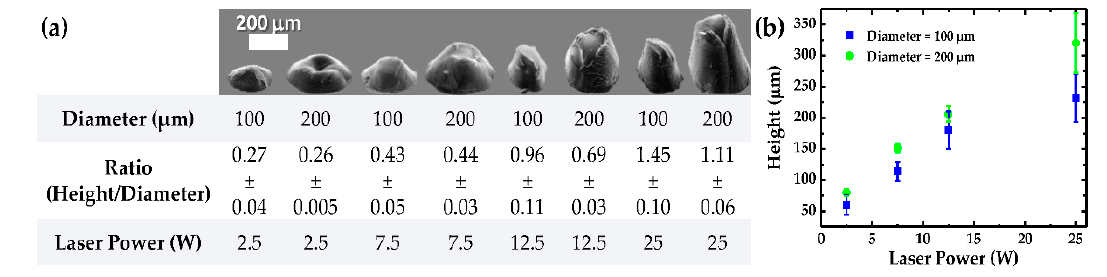
Figure 1. Effect of laser power on micro-structures peeled off from h-PDMS molds. ( a ) SEM images of micro-structures with the respective height/diameter ratio. ( b ) Height variation with laser